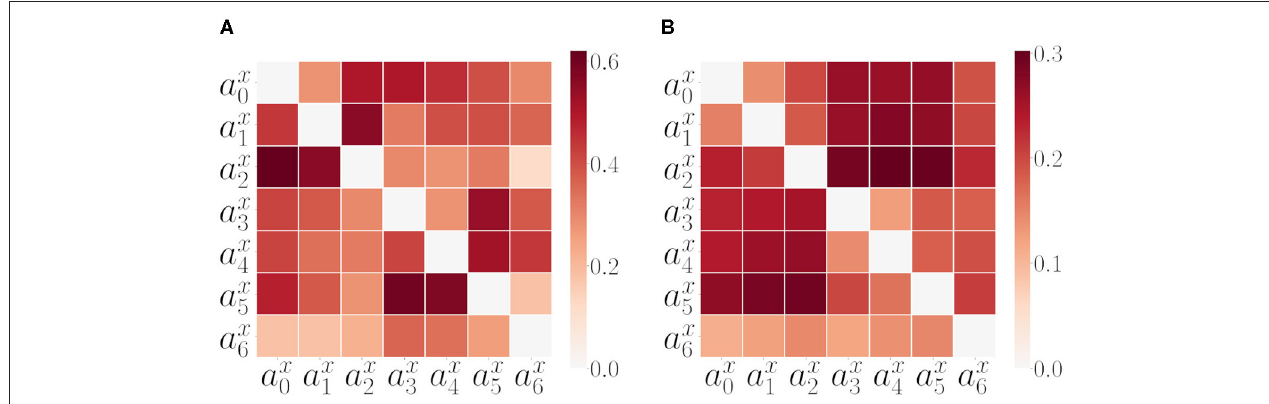
FIGURE 7 | Alternative measures: GC and TE. (A) Matrix of pairwise GC measure values among all SIPs for all SM interaction data. The matrix is computed considering the proportion of GC tests passed (refer to text for further details, section 3.3). (B) Matrix of pairwise TE measure values among all SIPs for all SM data.